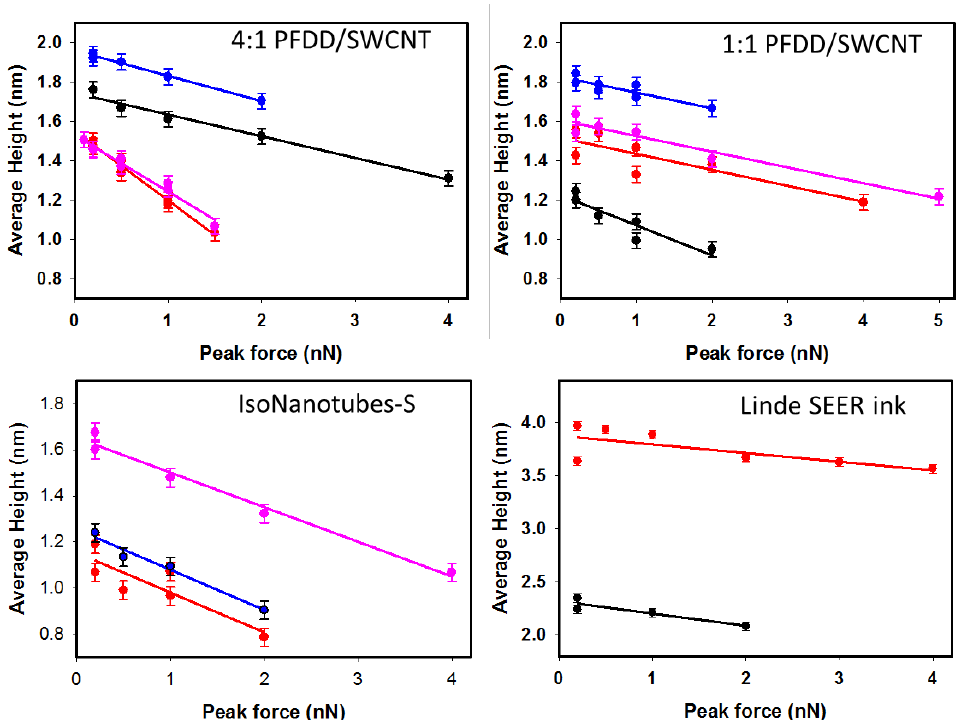
Figure 2. Average carbon nanotube network height as a function of AFM peak force measured on several different areas of four different SWCNT samples. In each graph, data points of the same color are obtained from consecutive AFM images of the same area.